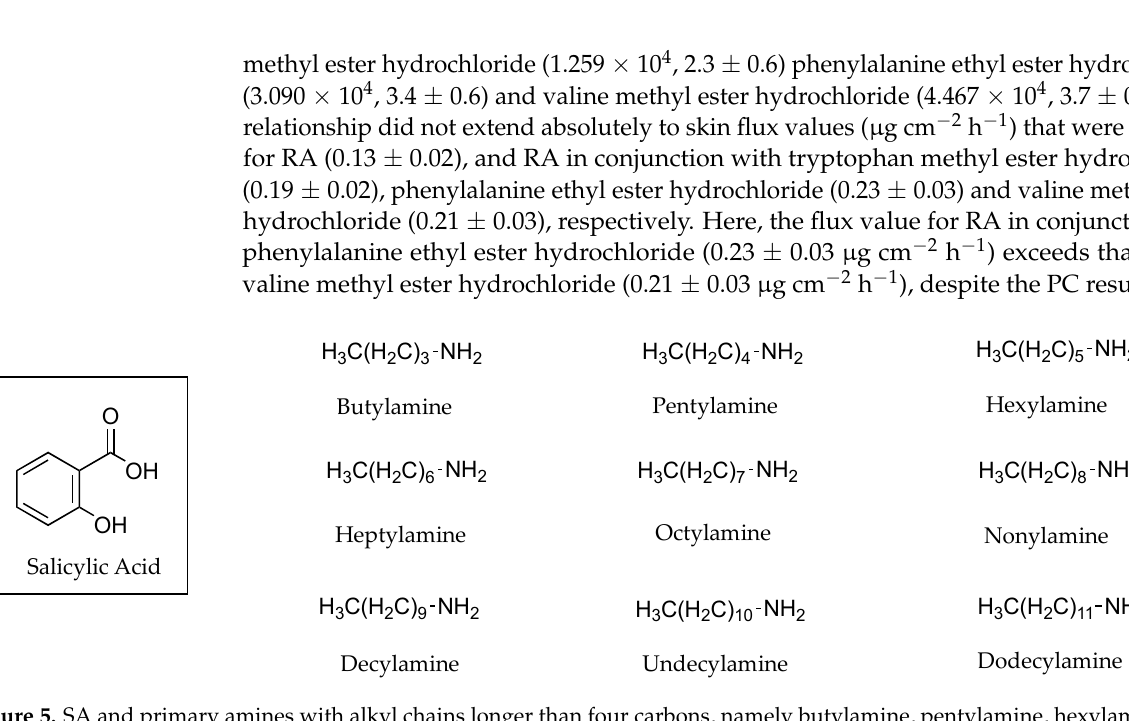
Figure 5. SA and primary amines with alkyl chains longer than four carbons, namely butylamine, pentylamine, hexylamine, heptylamine, octylamine, nonylamine, decylamine, undecylamine and dodecylamine.